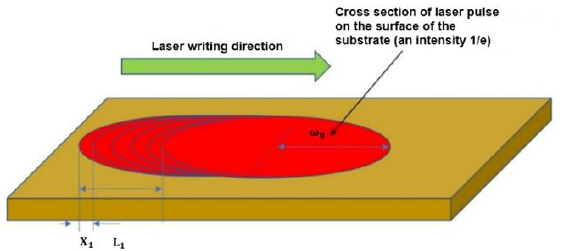
Figure 10. The schematic illustration of laser beam translation, used for thermal modelling. Here, X 1 is the subsequent pulse translation distance, L 1 is a distance of translation equal to ω 0 .